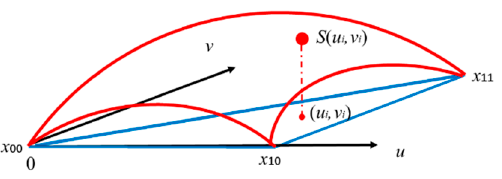
Figure 6. Mapping relationship between feature triangle and surface triangle.